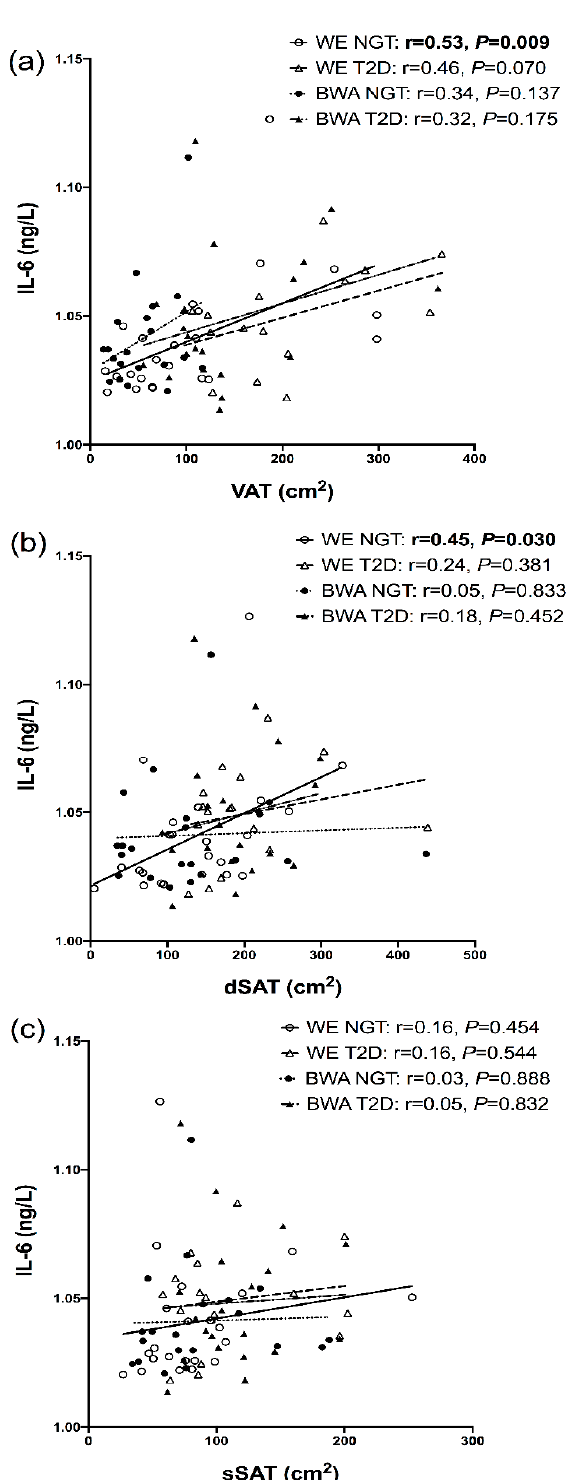
Figure 3. Relationships between interleukin-6 (IL-6) and visceral adipose tissue (VAT), ( a ), deep subcutaneous adipose tissue (dSAT), ( b ) and superficial SAT (dSAT), ( c ), in white European (WE) and black West African (BWA) men with normal glucose tolerance (NGT) and type 2 diabetes (T2D). IL-6 underwent a + 10 then log transformation to achieve a normal distribution in the positive axis. Bold p -values indicate significance of <